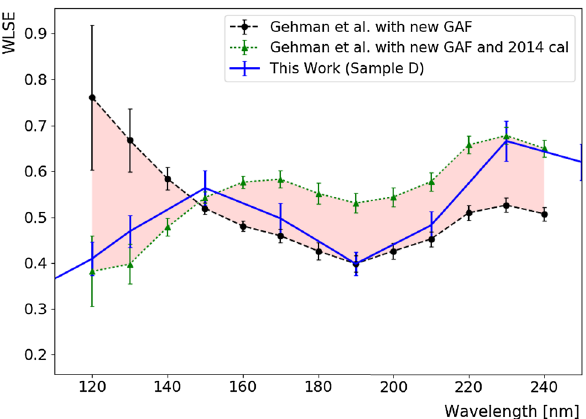
Fig. 24 A comparison of the relative response of samples as a function of TPB film thickness for evaporated TPB thin film data in [20],